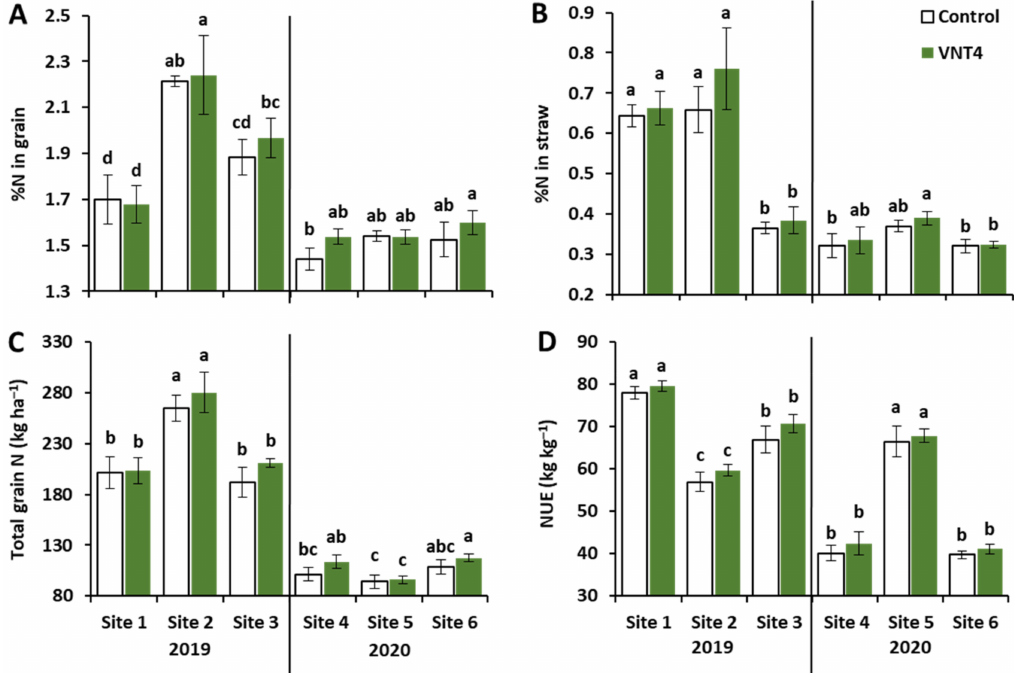
Figure 2. Influence of VNT4 on N-related traits in winter wheat under different site and year conditions. ( A ) N content in grain, ( B ) N content in straw, ( C ) total grain N and ( D ) NUE. Plant culture was carried out under six different field conditions in France, Normandy. N was provided at the tillering, stem elongation and flag leaf stages. 5 L ha − 1 of VNT4 formulation (see Table 1 for more details) were mixed with UAN before each N application, leading to a global application of 15 L ha − 1 . Bars indicate means ± SE. Different letters denote significant differences in 2019 or 2020 according to Fisher’s test ( p < 0.05; n = 3 in 2019, n = 4 in